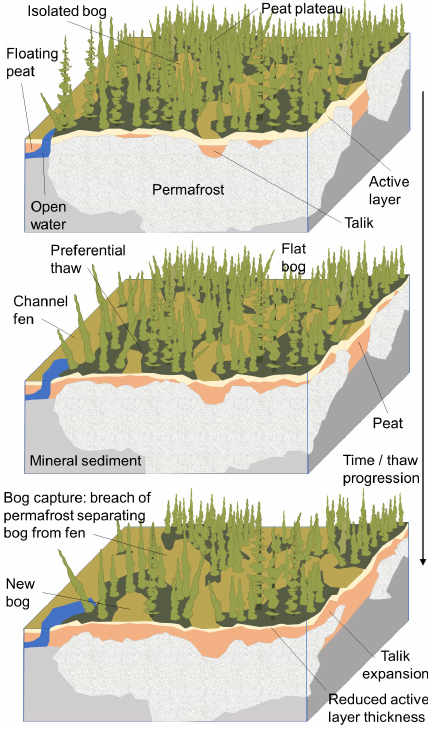
Figure 8. Conceptual model of forest canopy thinning and per- mafrost thaw in the Taiga Plain, after Quinton et al. (2009, 2019) and Connon et al.